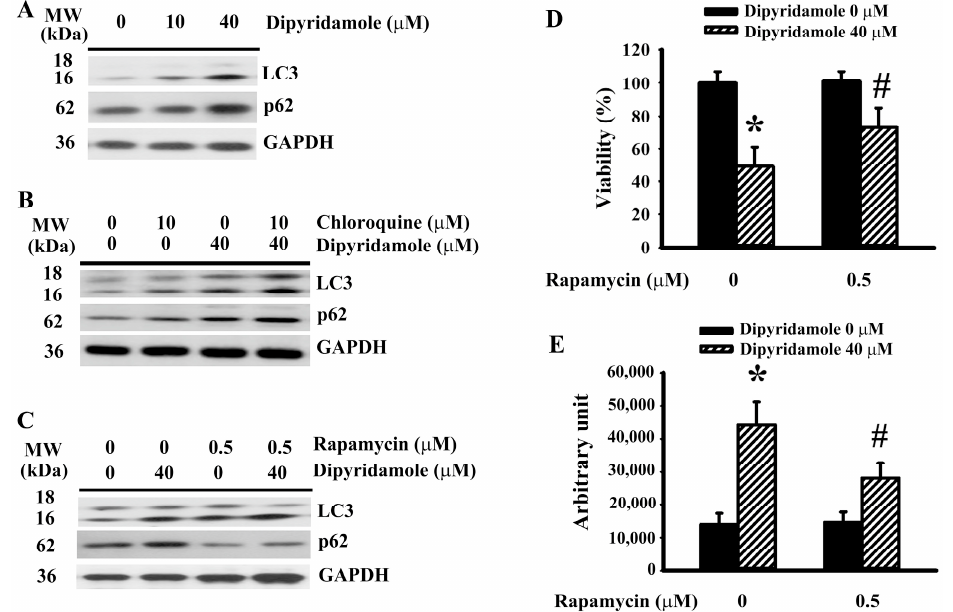
Figure 4. Dipyridamole impaired autophagic flux in U87 cells. ( A ) U87 cells were treated with various concentrations of dipyridamole, as indicated for 12 h. Proteins were determined using western blotting with indicated antibodies. Representative blots are shown. ( B ) U87 cells were treated with dipyridamole (0 and 40 µ M) in the presence or absence of chloroquine (10 µ M) for 12 h. Proteins were determined using western blotting with indicated antibodies. Representative blots are shown. U87 cells were treated with dipyridamole (0 and 40 μ M) in the presence or absence of rapamycin (0.5 μ M). ( C ) Proteins (12 h) were determined using western blotting with indicated antibodies. Representative blots are shown. ( D ) Cell viability (24 h) was determined using MTS reduction assay. ( E ) Caspase 3 activity (12 h) was measured using an enzymatic assay. * p < 0.05 vs. untreated control and # p < 0.05 vs. dipyridamole (40 μ M) control, n = 4.